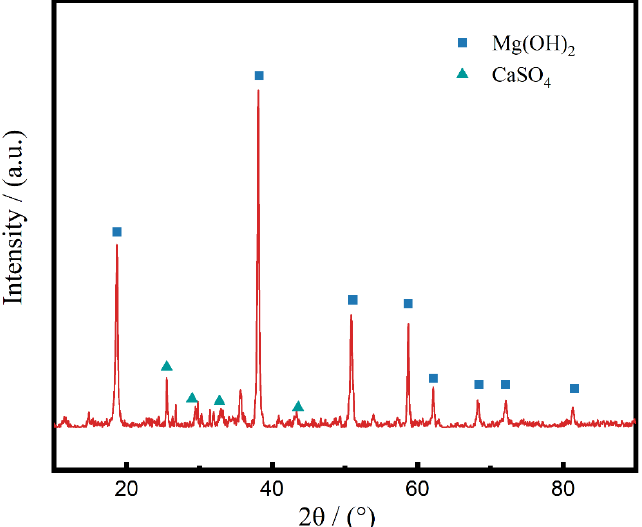
Figure 5. The XRD result of the white deposits.